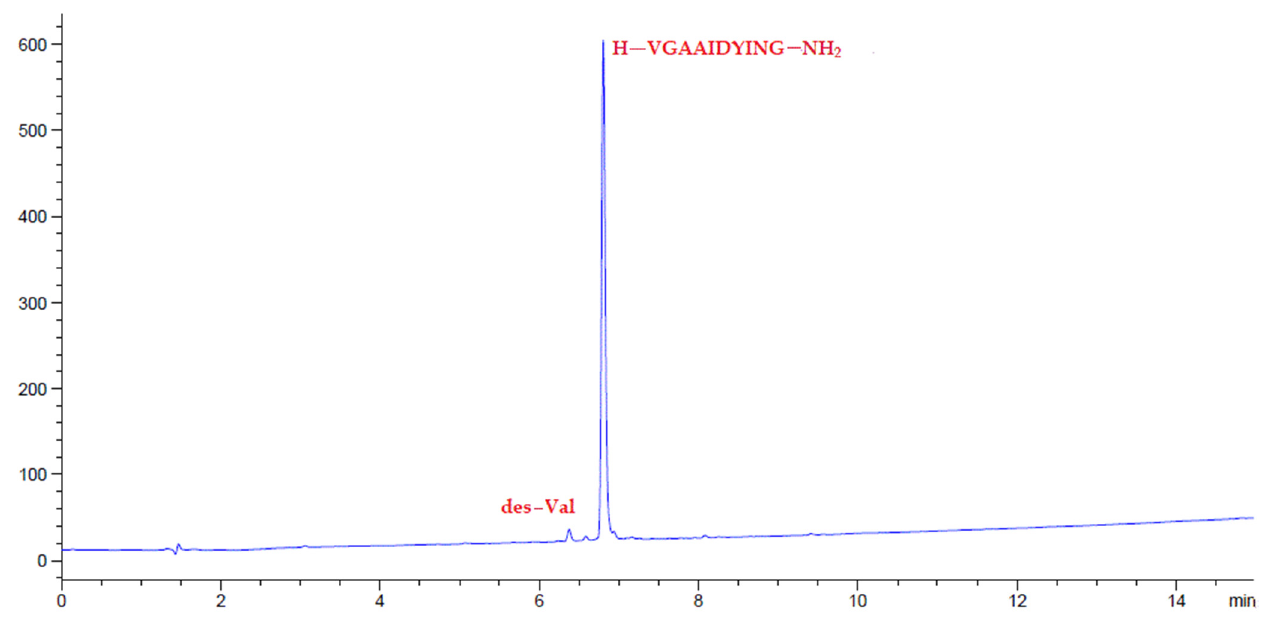
Figure 9. HPLC chromatograms of crude peptides H-VGAAIDYING-NH 2 after precipitation.